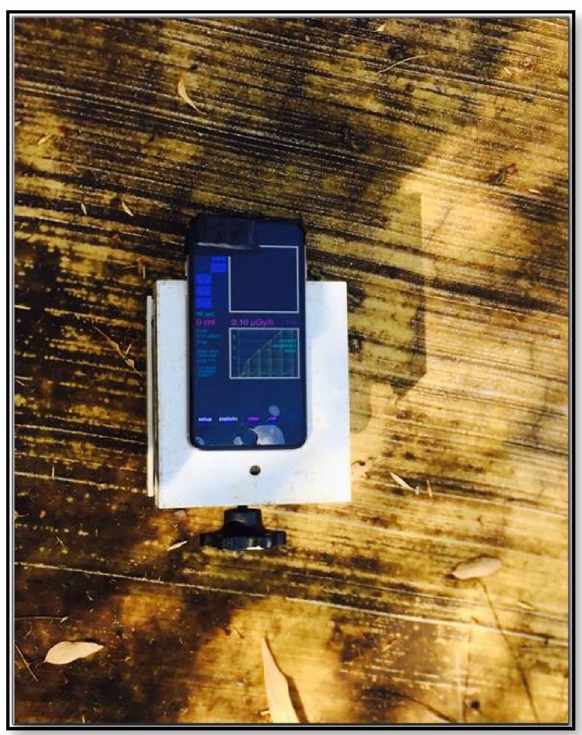
Figure 10. Measurement setup with stand.